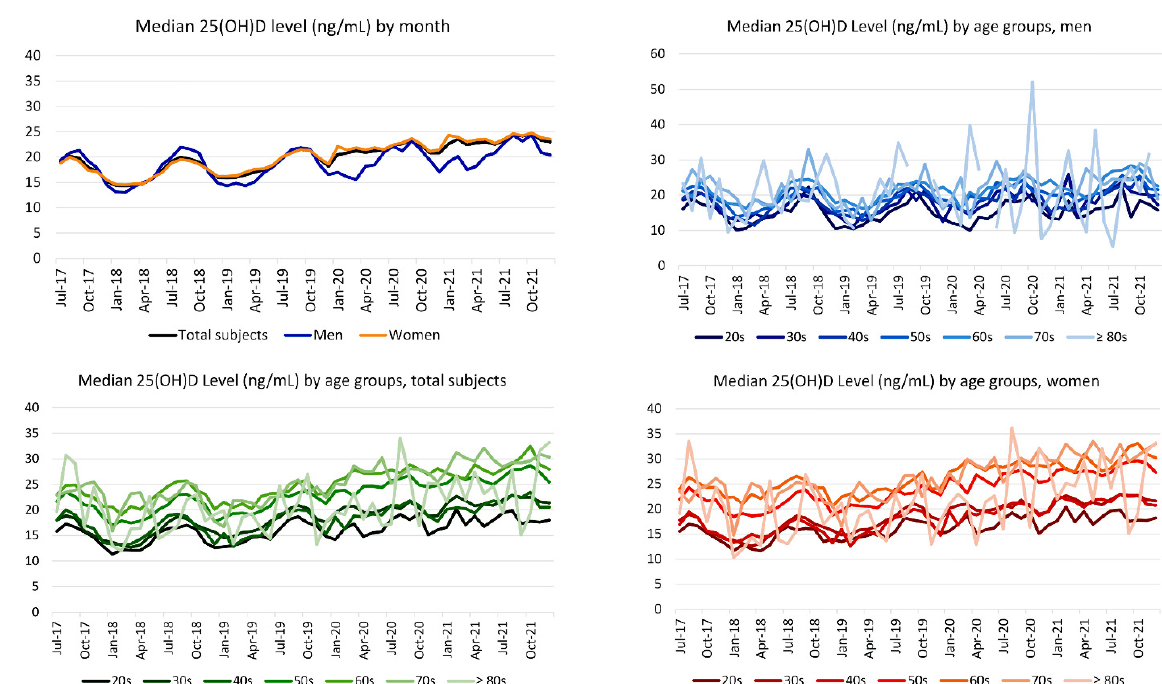
Figure 3. Prevalence of each vitamin D status based on 25(OH)D level by sex, age, and test month and year.